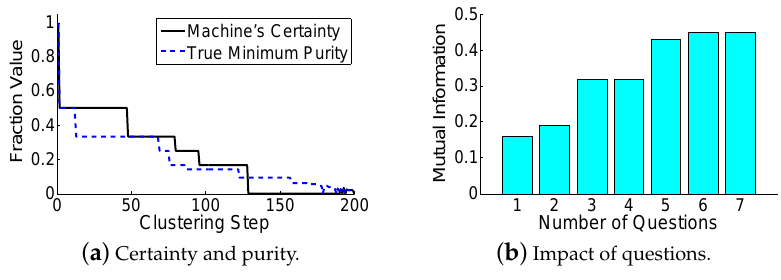
Figure 8. Evaluation results for the LFW Data